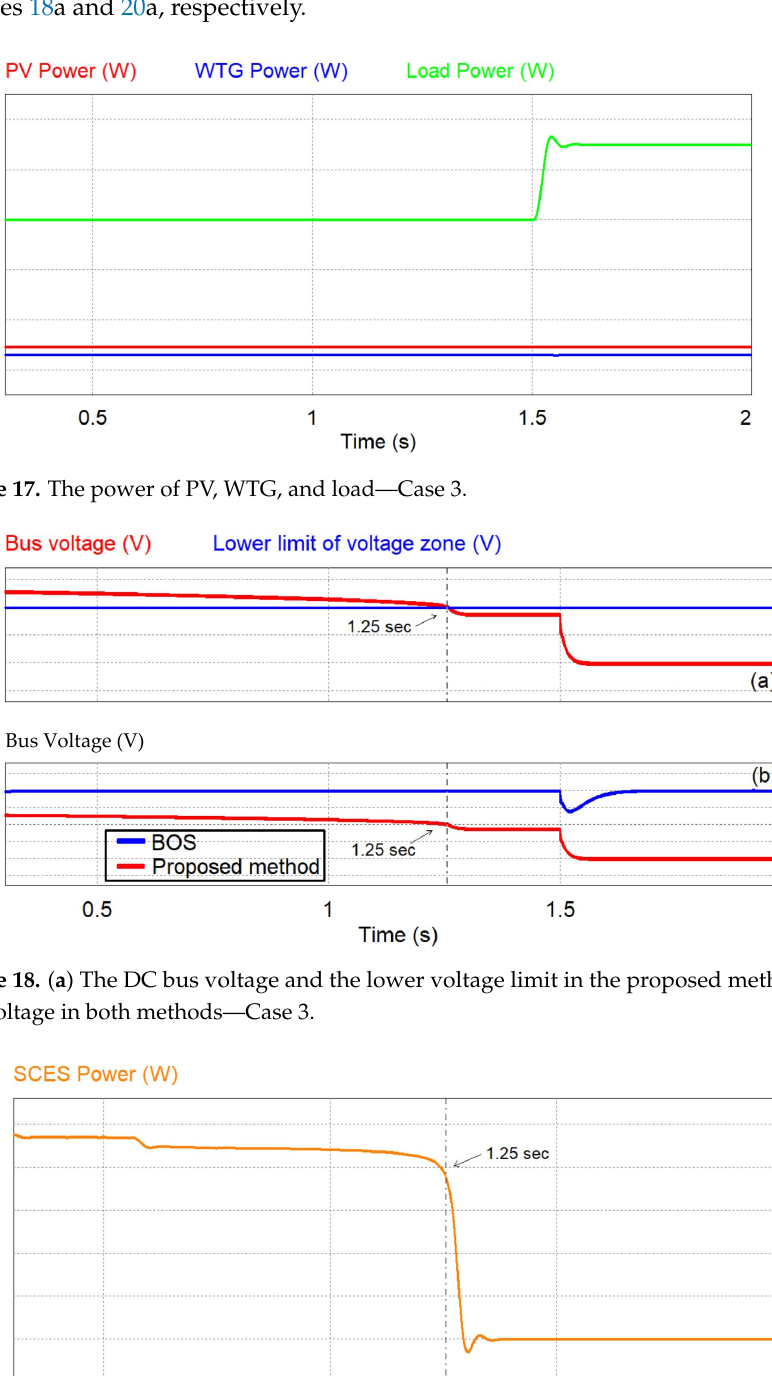
Figure 20. ( a ) The ba tt ery current; ( b ) the ba tt ery power—Case 3. 4.1.4. Comparison among the Previous Cases Table 6 presents a comprehensive comparison among the previous three assessments in the presence of a BOS and a SCES/ba tt ery HESS controlled with the proposed method. The comparison includes the maximum DC bus voltage deviation from its nominal value, the ba tt ery status, and the ba tt ery current variations. From this table, it can be concluded that the SCES eliminates the frequent cyclic activity for the ba tt ery and reduces its current variations when the bus voltage is outside the narrow zone. Therefore, the presented scheme prolongs the ba tt ery’s lifespan. Table 6. Comparison among the previous assessments in the presence of a BOS and a SCES/ba tt ery HESS controlled with the proposed scheme. Case